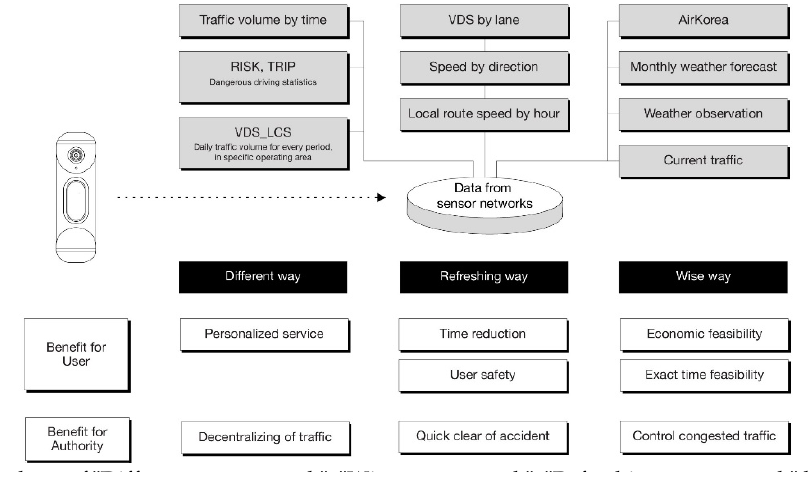
Figure 12. Database of "Different way to work", "Wise way to work", "Refreshing way to work" linked to APIs.